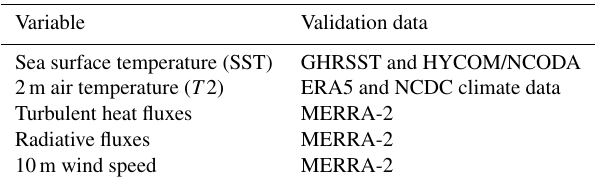
Table 2. The observational data and reanalysis data used to validate the simulation